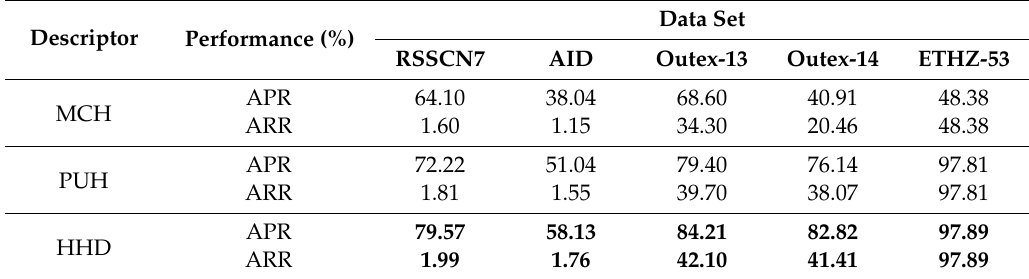
Table 7. Average precision rate (APR) and average recall rate (ARR) of the proposed